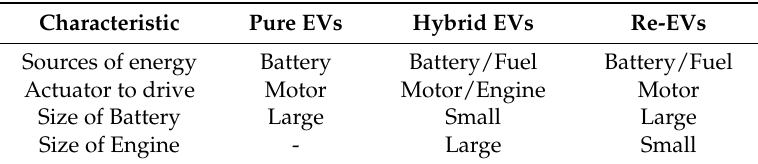
Table 1. Comparison by type of electric